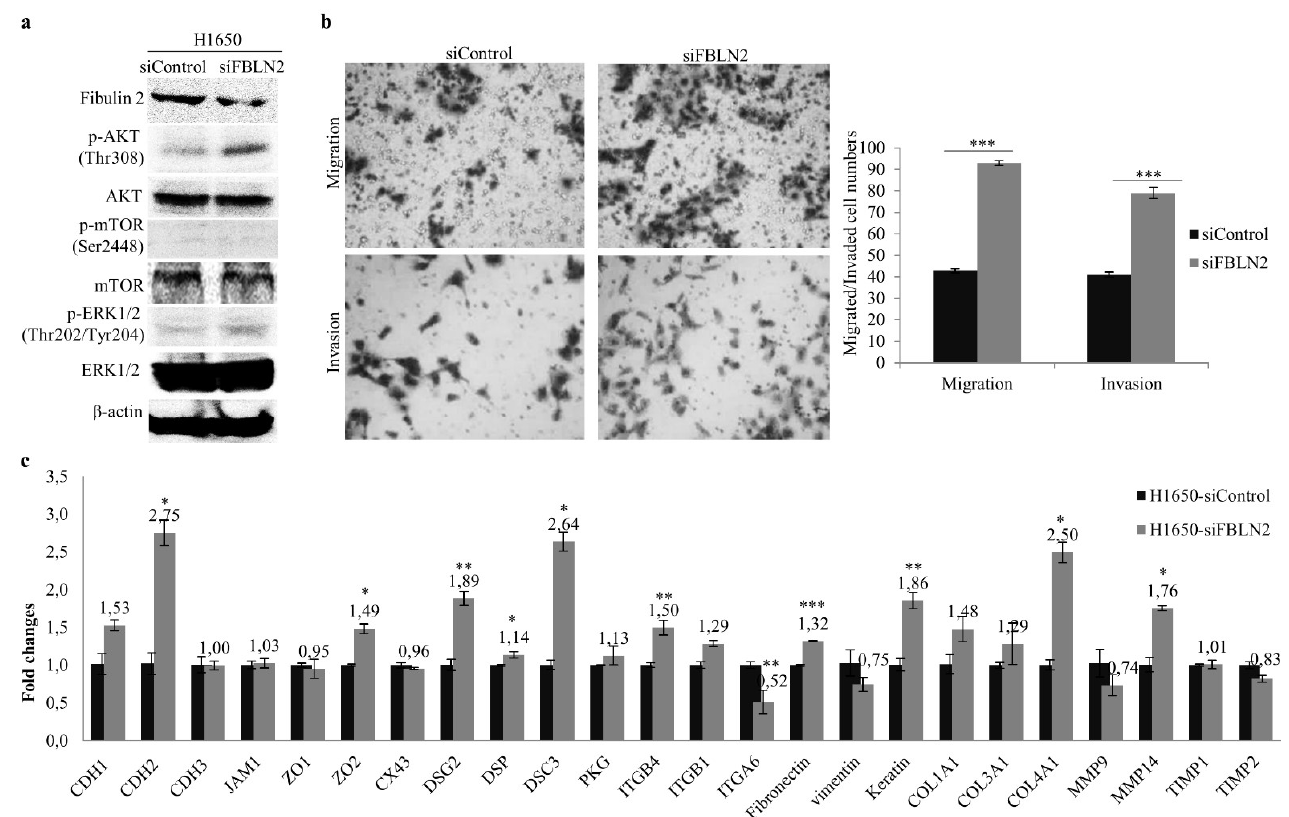
Figure 5. Effect of siRNA knockdown of FBLN2 on MAPK and AKT pathways and lung cancer cell migration/invasion. ( a ) Left: Downregulation of FBLN2 by siRNA-FBLN2 led to enhanced phosphorylation levels of ERK and AKT. ( b ) FBLN2 knockdown increased the cell migration/invasion. ( c ) FBLN2 gene silencing influenced the expression levels of cell adhesion and ECM genes, as revealed by real-time RT-PCR. mRNA expression level compared to GAPDH in cells transfected with siRNA-Control was set to 1.0. * p < 0.05, ** p < 0.01, *** p < 0.001.